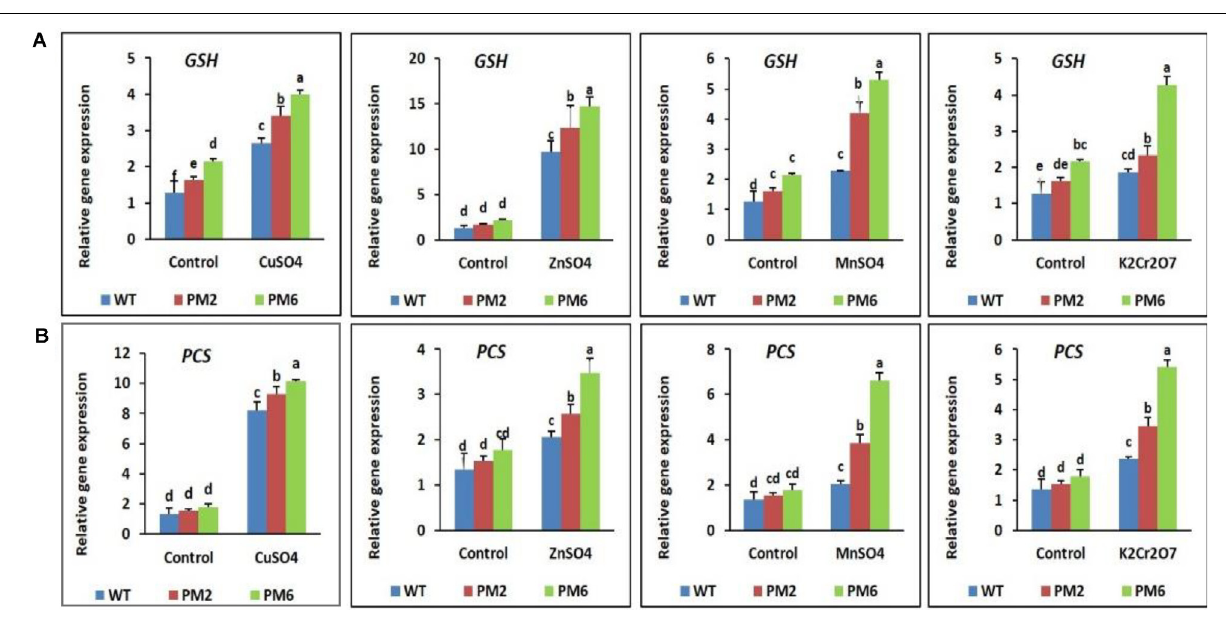
FIGURE 9 | Expression analysis of the heavy metal stress tolerance genes glutathione S-transferase [ GST, (A) ] and phytochelatin synthase [ PCS, (B) ] in the T 2 -PM6, T 2 -PM2, and WT plants after exposure to the indicated heavy metals. Data were taken on the thirtieth day after starting the experiments. Error bars show the